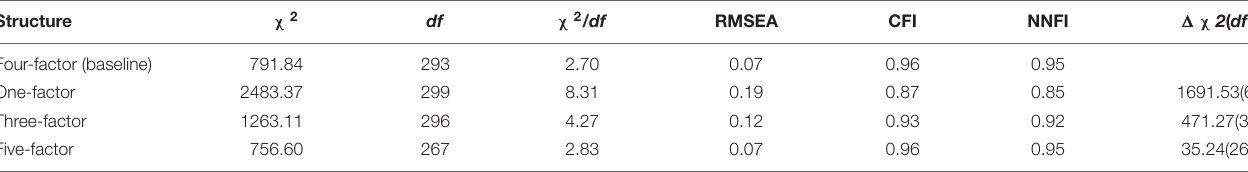
TABLE 1 | Comparison of measurement models.